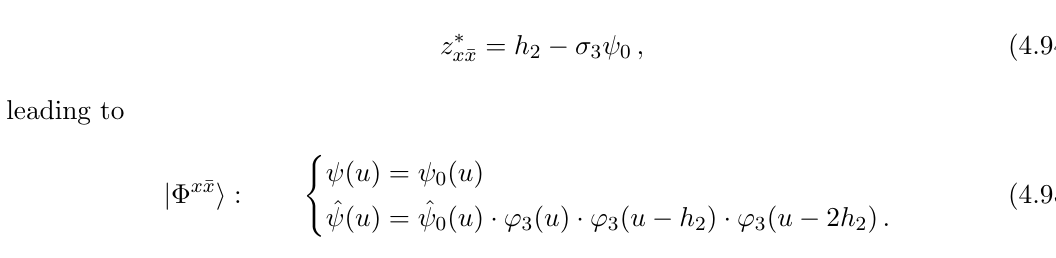
[ 2 i can be produced by applying x ( z ) on j j